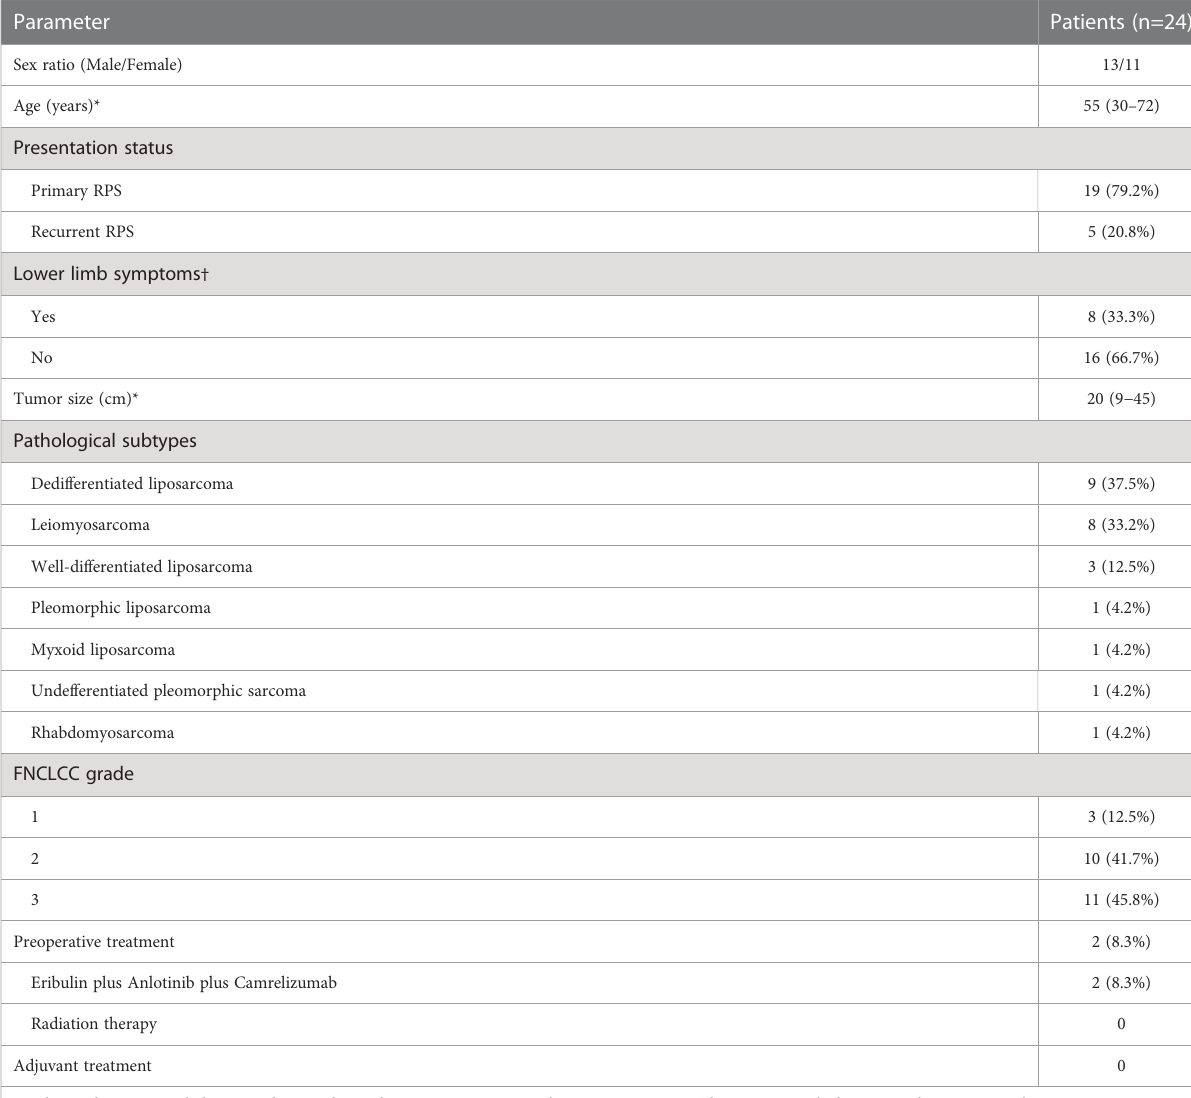
TABLE 1 Clinicopathological characteristics of patients.